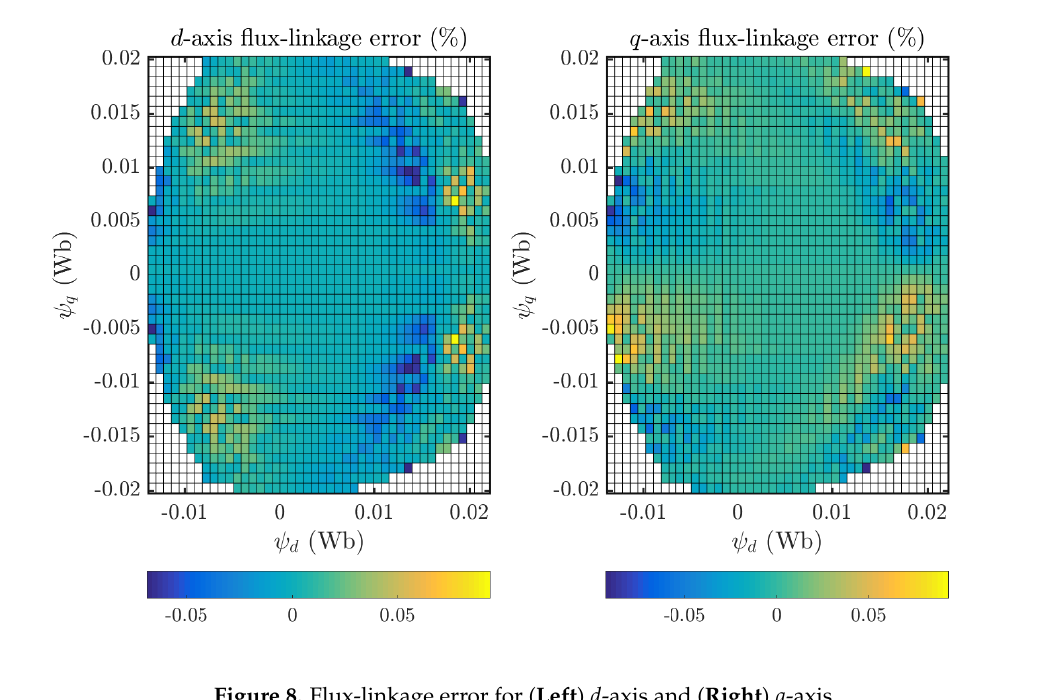
Figure 8. Flux-linkage error for ( Left ) d -axis and ( Right ) q